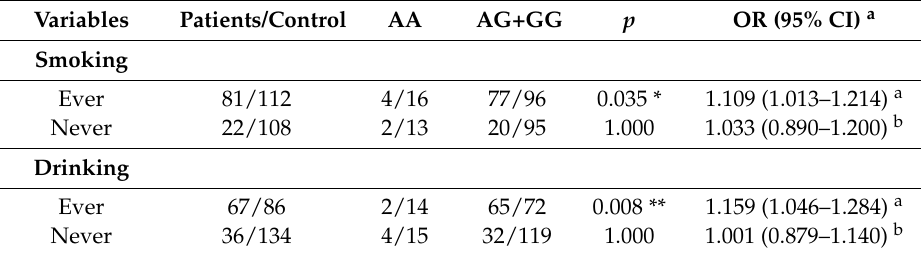
Table 5. Stratification analysis of the strength of the association between UGT1A1 rs4148323 and laryngeal